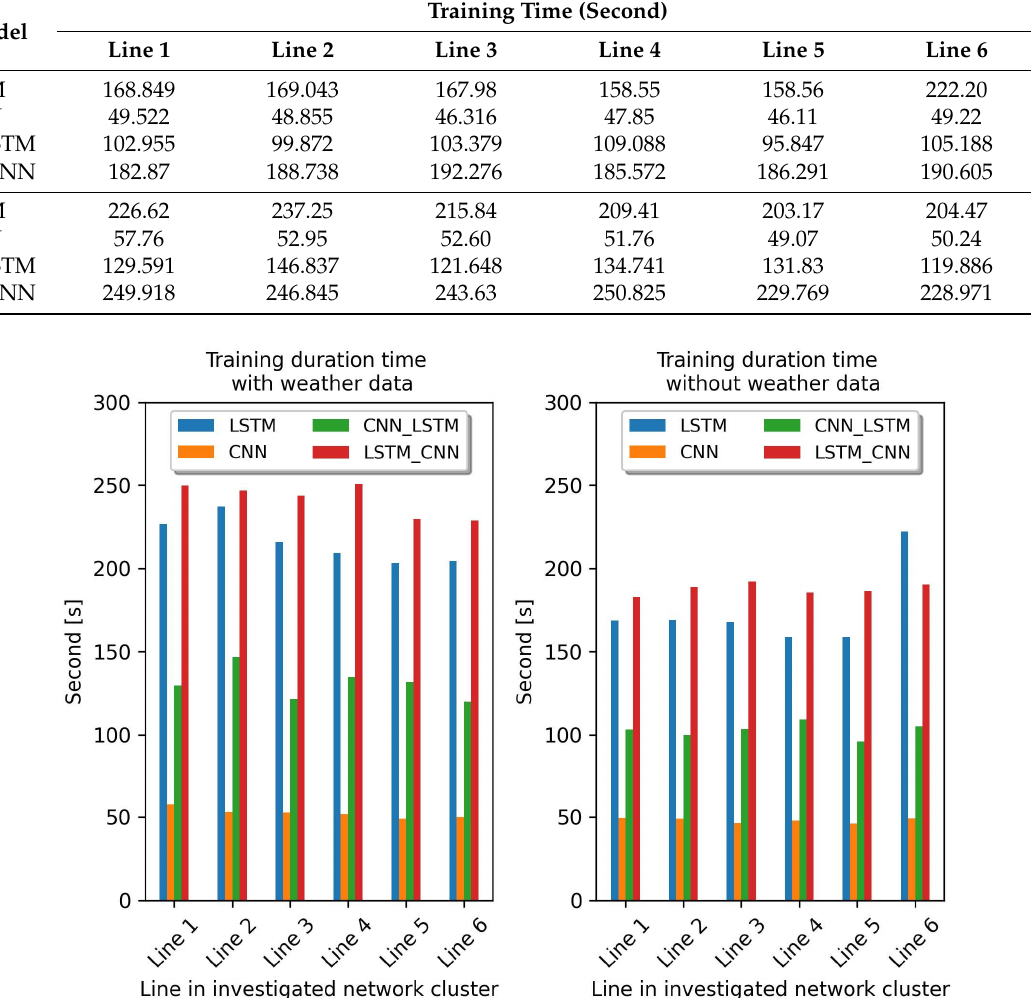
Figure 10. Prediction results of the power flow direction based on real power measurement data only.